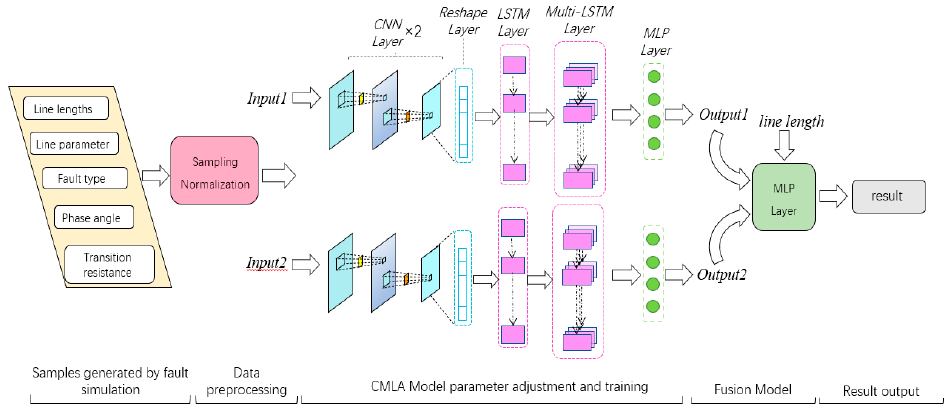
Figure 4. Architecture of the fault location.